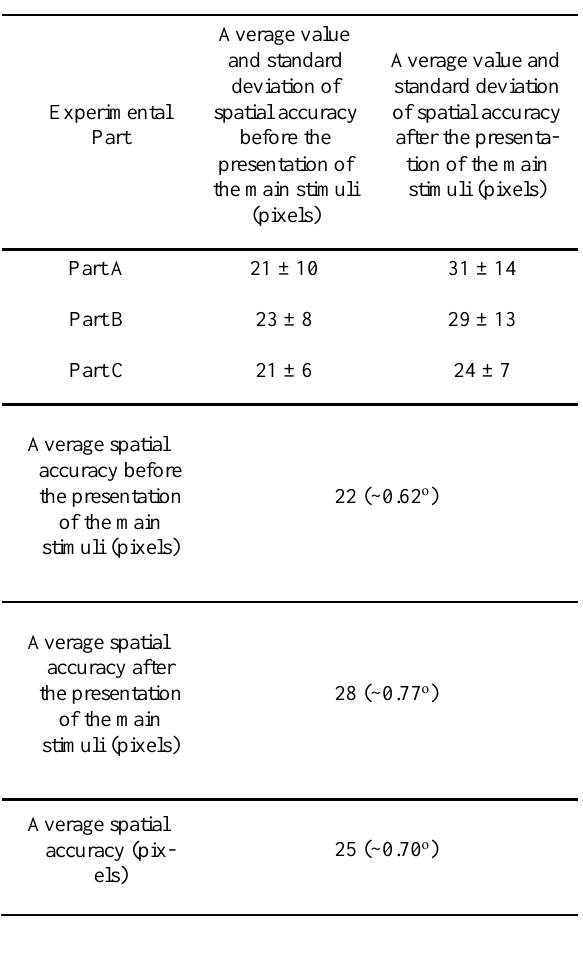
Average value and standard deviation of spatial accuracy before and after the presentation of the main stimuli for all experimental Parts and in